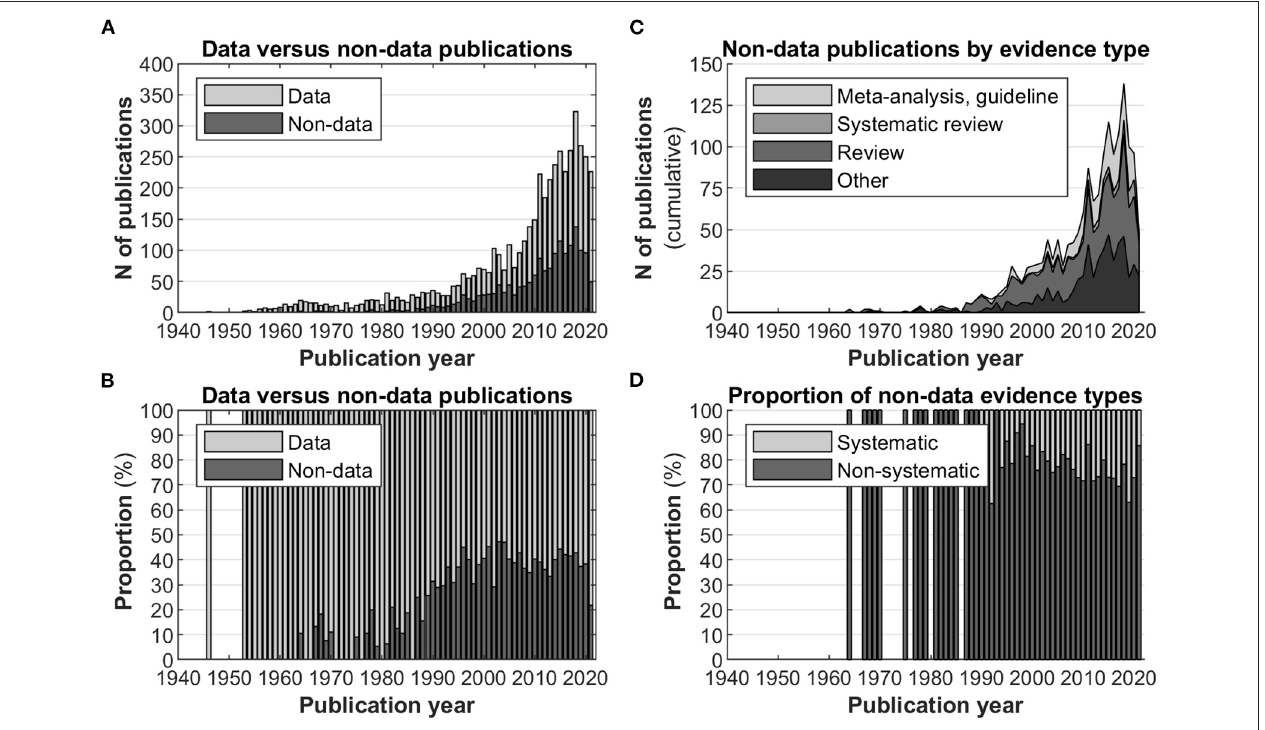
FIGURE 7 | Data vs. non-data publications, excluding uninformative publication types. (A) Histograms of data articles vs. non-data articles in the database. (B) Proportion (in percent) of data vs. non-data publications. In recent years, this ratio is relatively stable, with the majority of the articles considered data publications. (C) Breakdown of the evidence types of non-data publications. (D) Proportion of non-data evidence types categorized in non-systematic or systematic. Systematic evidence types are increasingly